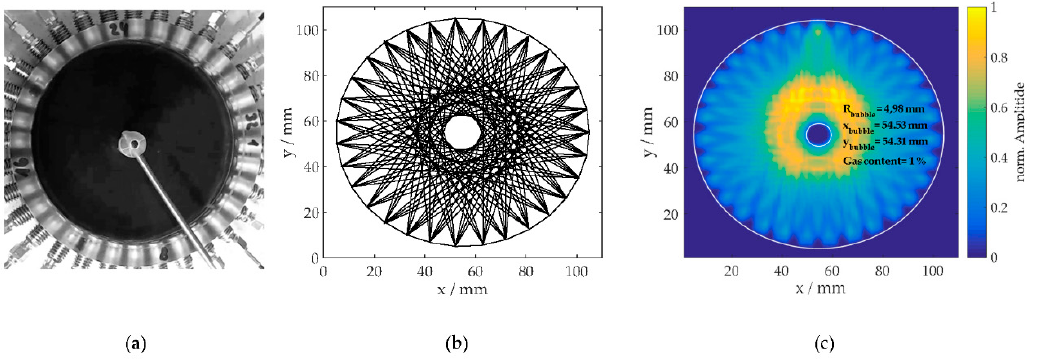
Figure 6. Detection of bubble position and size, ( a ) top-view picture recorded with a camera, ( b ) reconstructed images from full transmission measurement scans with 224 projections, ( c ) image post processing (filtering) and circle